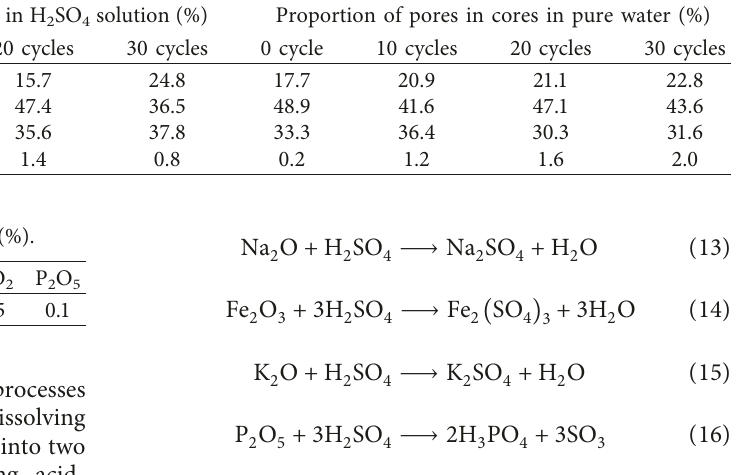
Table 3: Proportional variations of pore sizes in different solutions. Proportion of pores in cores in H 2 SO 4 solution (%) Proportion of pores in cores in pure water (%) Pore size